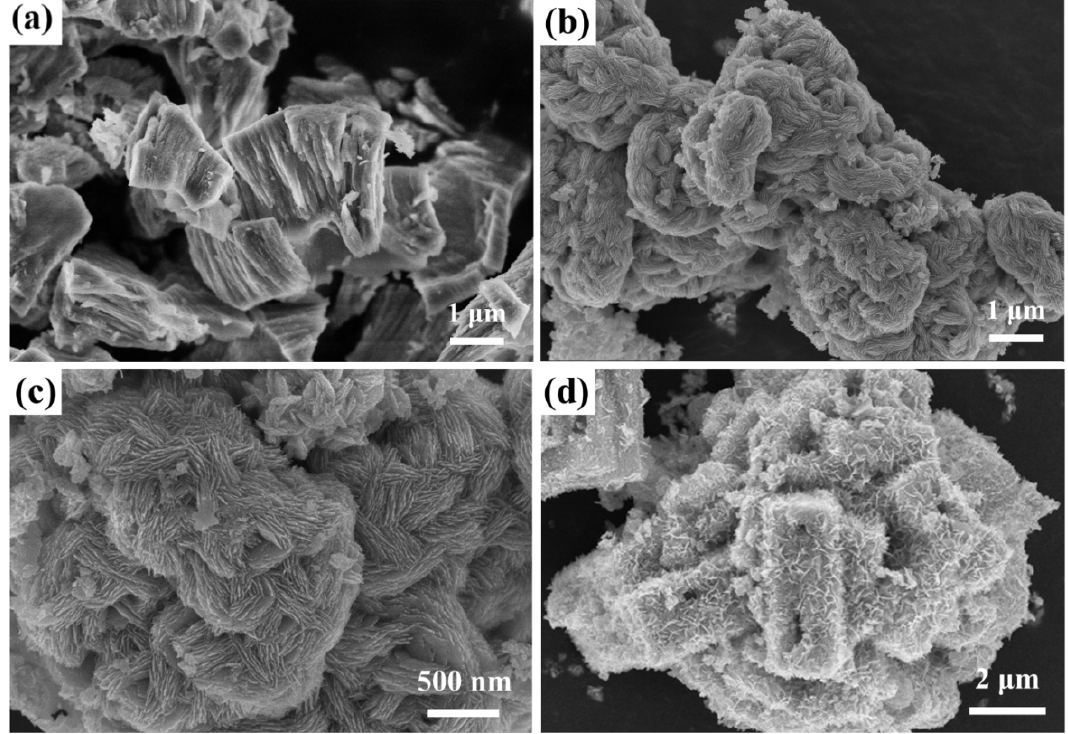
Figure 2. Scanning electron microscopy (SEM) images of calcined mussel shell (CMS) ( a ), Bi 2 WO 6 ( b , c ), and CMS/BWO-2 ( d ).